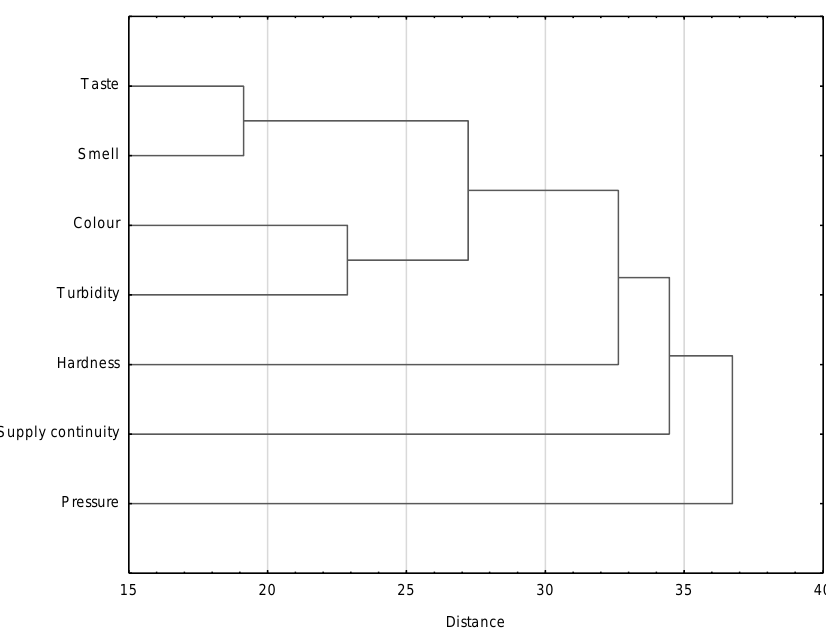
Figure 6. Dendrogram obtained for the analysed tap water parameters in terms of their evaluation in the spring period (results of cluster analysis by agglomeration).